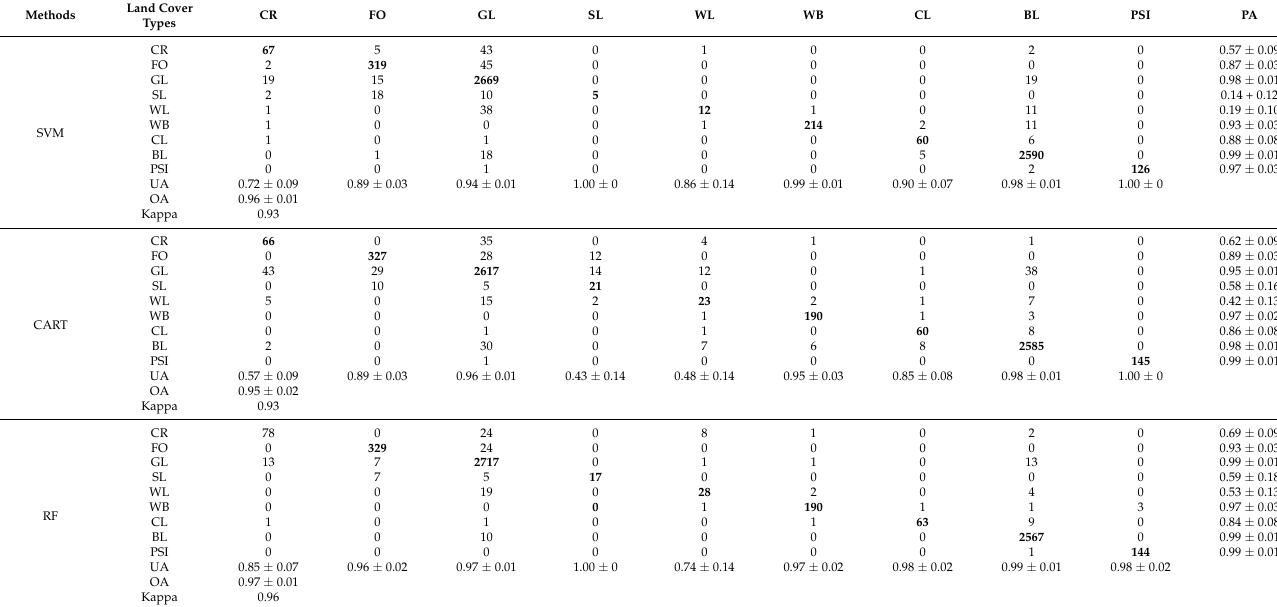
Table 3. Confusion matrix of the classification results of the three remote sensing classification algorithms.